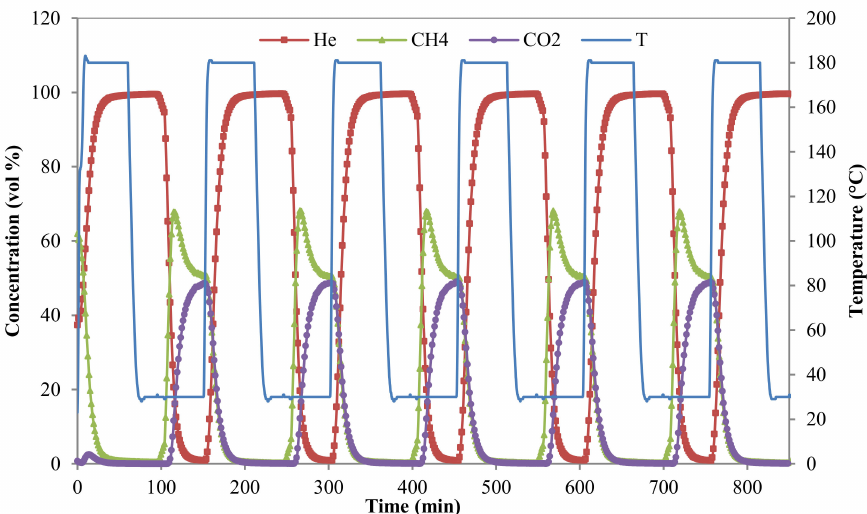
Figure 6. Breakthrough experiments composed of six successive sorption cycles for an equimolar CO 2 /CH 4 gas mixture at 1 bar. (Solid lines with symbols represent the concentration profiles of CH 4 , CO 2 and He. The blue solid line represents the temperature).